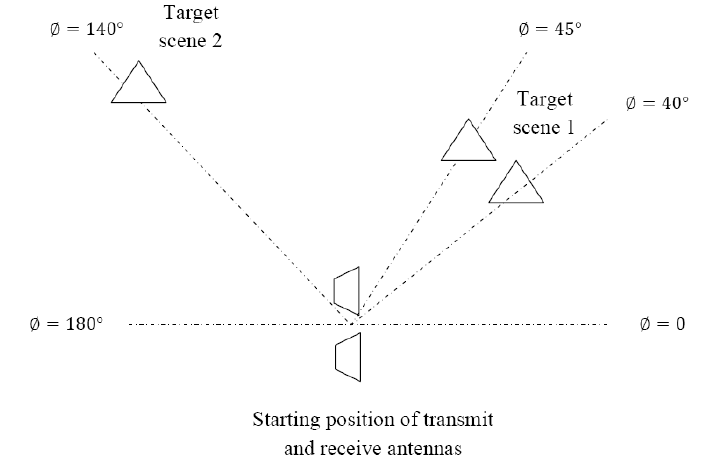
Figure 13. Diagrammatic representation of Target Scenario 6.